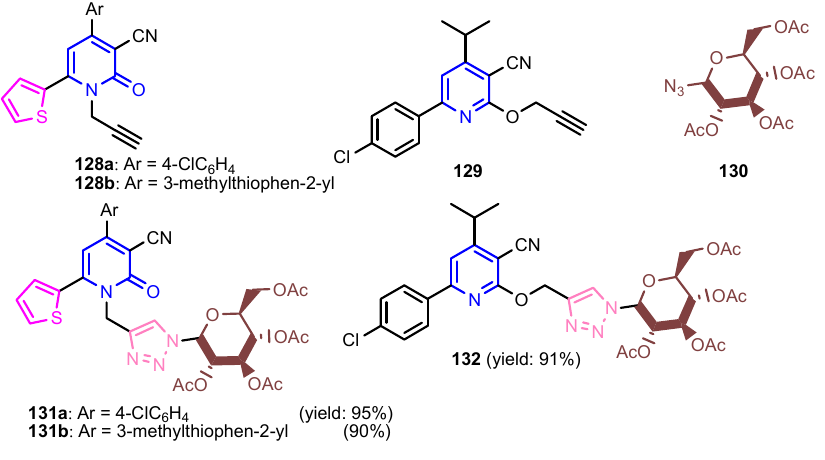
Figure 13. Structures of compounds 128 − 132 [58]. Table 6. Antimicrobial activity (MIC values in µg mL − 1 ) of pyridine triazoles 122a − 122k [57]. Compd.